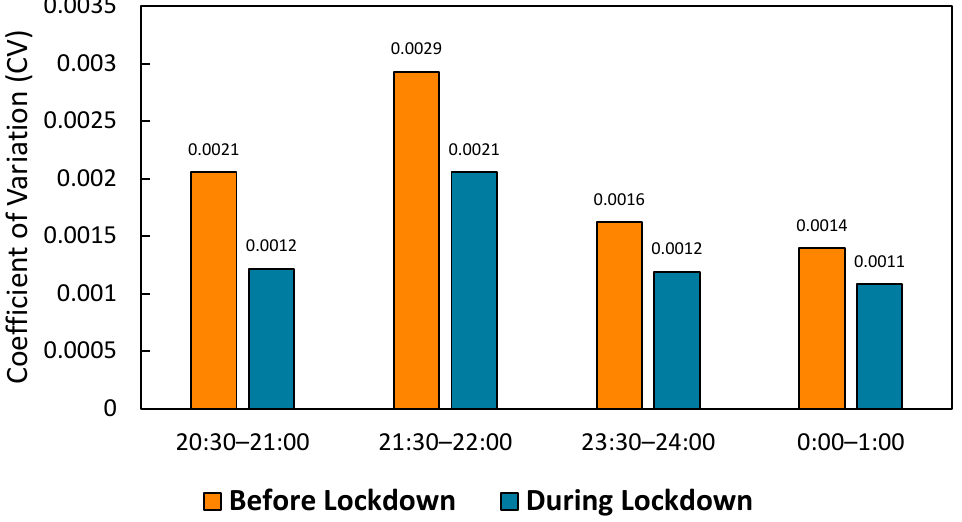
Figure 6. Average coefficients of variation (CV) at four typical time intervals before and during the COVID-19 lockdown.